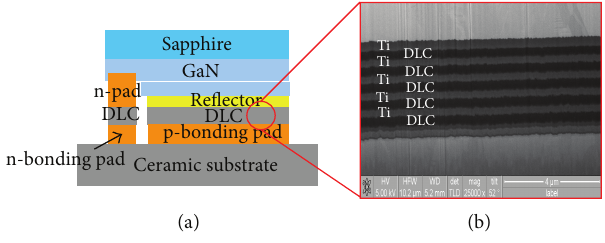
Figure 1: (a) Schematics of the FCLED with DLC heat-spreading layer. (b) Cross-sectional DLC heat-spreading layer SEM image for FCLED.